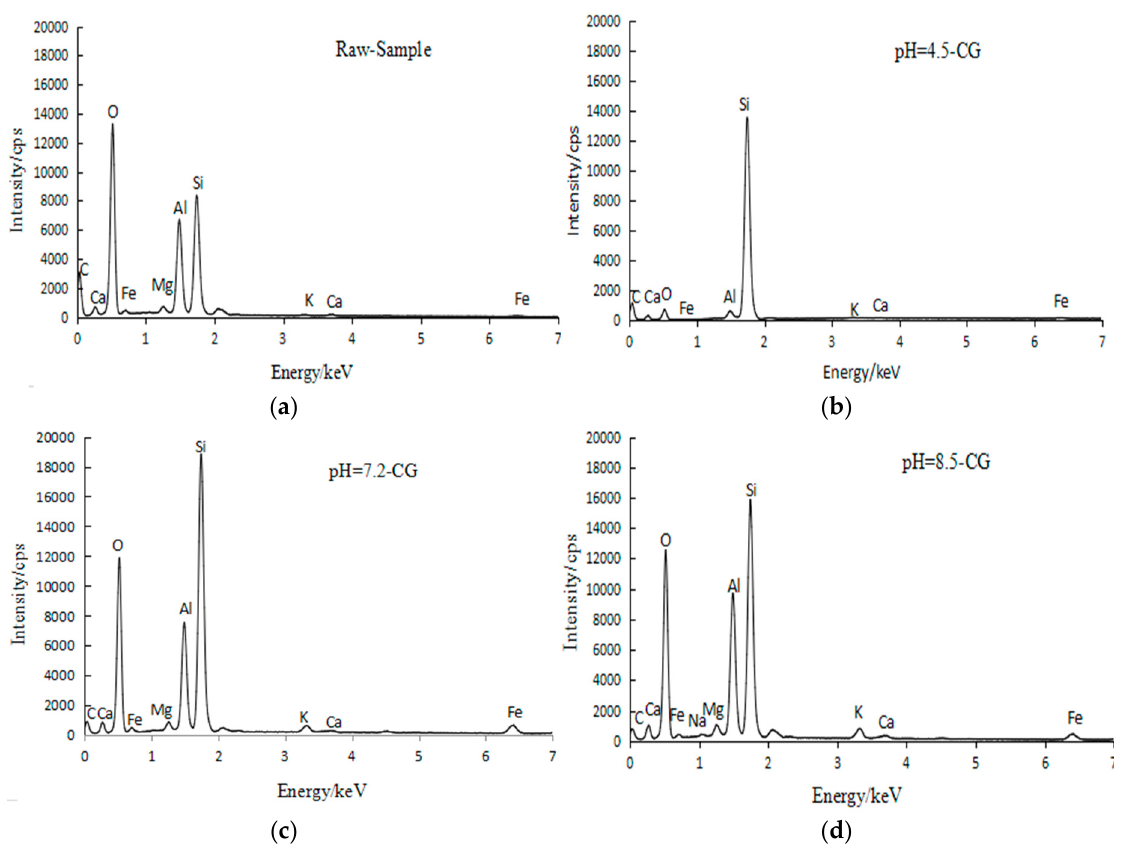
Figure 4. EDS spectrum in SEM images of coal gangue. ( a ) Raw-CG sample; ( b ) pH = 4.5-CG; ( c ) pH = 7.2-CG; ( d ) pH = 8.5-CG.